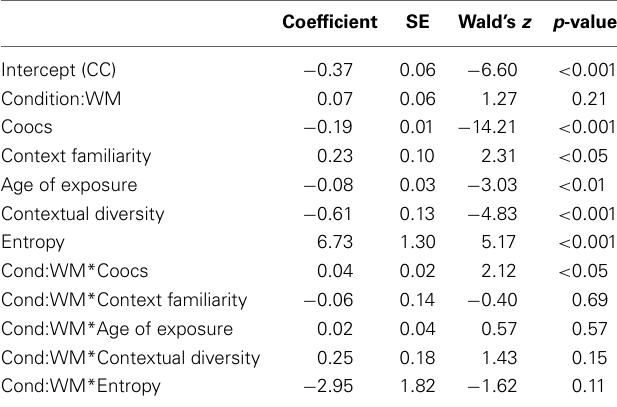
Table 2 | Regression coefficients predicting